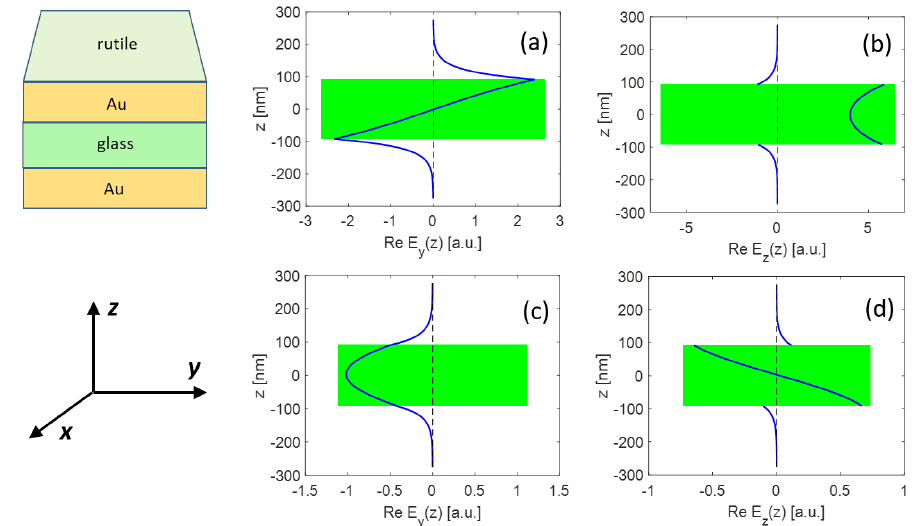
Figure 4. Electric field components in the MIM structure Au–SiO 2 184 nm–Au coupled with rutile prism. Incidence plane is perpendicular to the x axis. ( a , b ) LR SPP with odd longitudinal field symmetry at resonance incidence angle 19.8 deg; and ( c , d ) SR SPP with even longitudinal field E y ( z ) symmetry, incidence angle 44.4